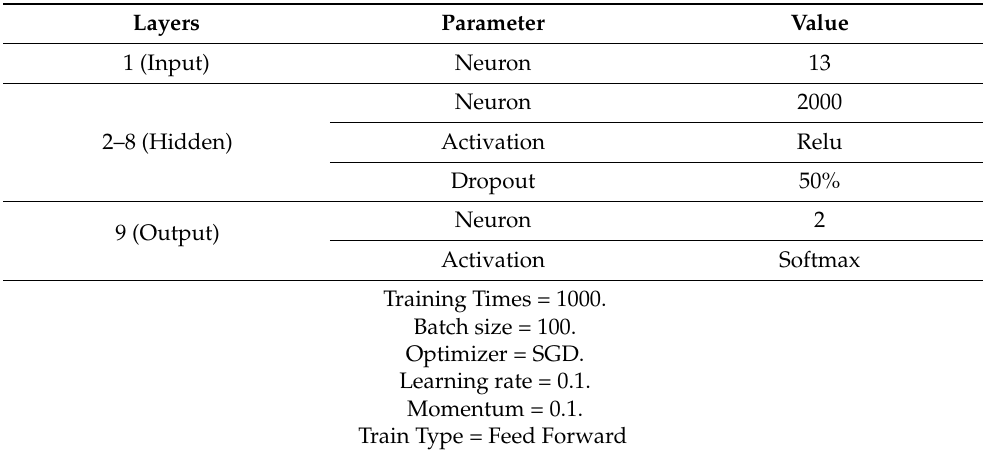
Table 5. Parameters of DNN